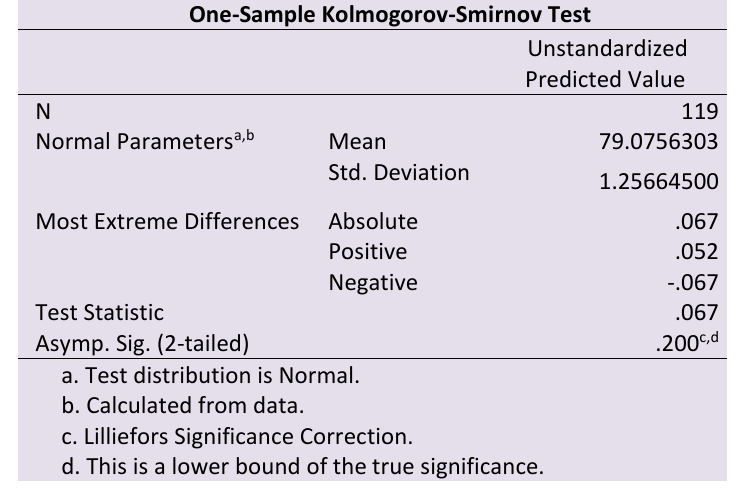
Table 4. Normality Test